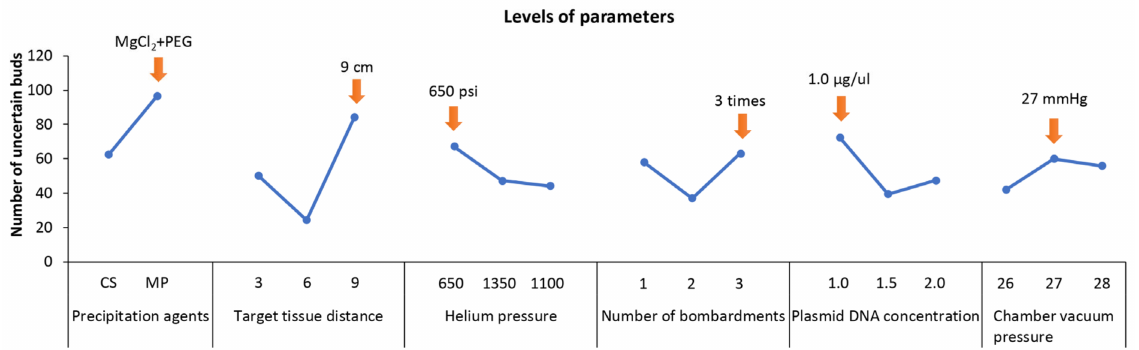
Figure 2. Effect of different levels of six parameters on the survival of adventitious buds after three cycles of